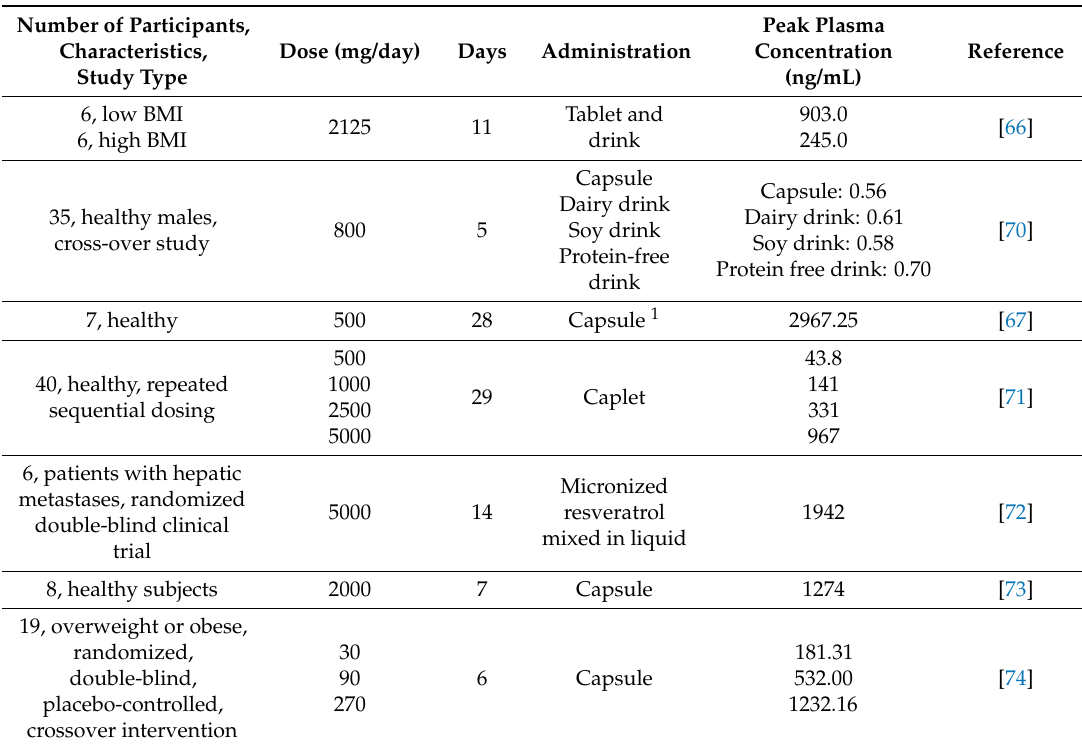
Table 3. Reported resveratrol plasma concentration in humans after repeated doses of resveratrol (studies after